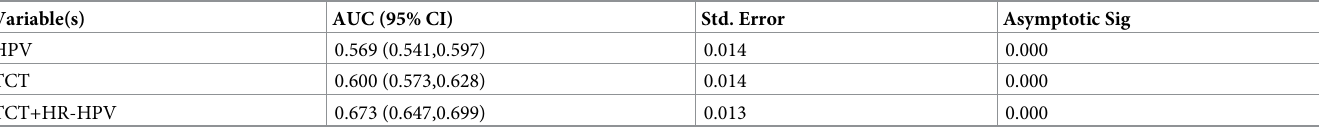
Table 6. The areas under the curve (AUCs) of different screening strategies for 1622 patients with cervical lesions.